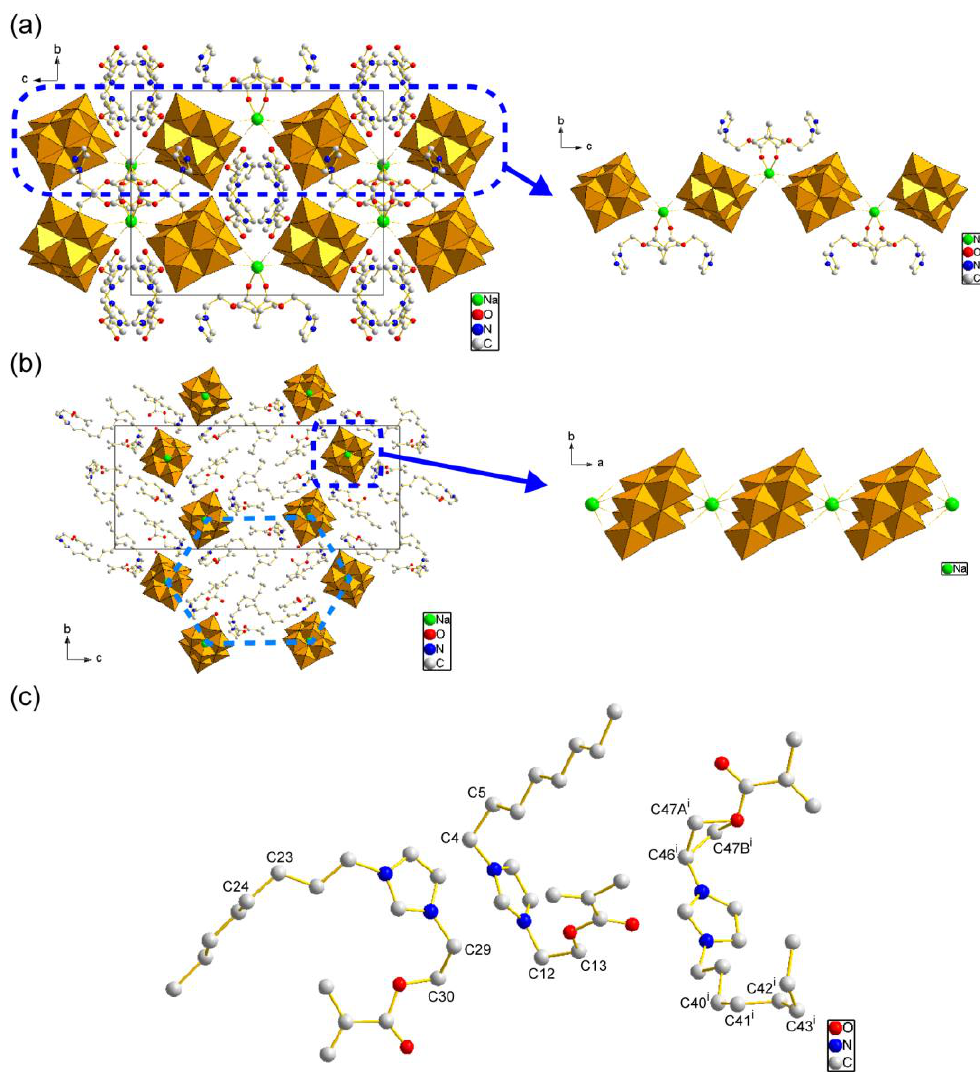
Figure 3. Crystal structures of Mo 8 hybrid crystals (Na: green, C: gray, N: blue, O: red). Mo 8 anions are represented by polyhedrons. H atoms are omitted for clarity; ( a ) packing diagram of 1 (left, along a axis) and molecular arrangement of the Mo 8 –Na + 1D chain in 1 (right, along a axis); ( b ) packing diagram of 2 (left, along a axis) and molecular arrangement of Mo 8 -Na + 1D chains in 2 (right, along c axis). A honeycomb-like arrangement of Mo 8 –Na + 1D chains is highlighted by a light-blue broken hexagon; ( c ) molecular conformations of crystallographically independent MAImC 8 cations in 2 . C atoms relevant to the gauche conformation are numbered. Symmetry code: ( i ) 1− x , −0.5+ y , 0.5− z .